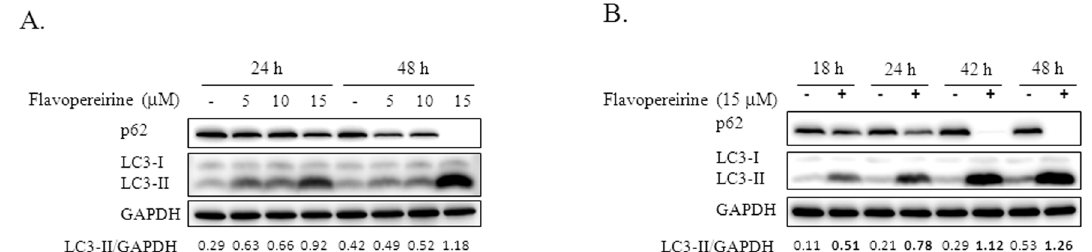
Figure 1. Flavopereirine induced LC3-II accumulation in dose- and time-dependent manners. ( A )